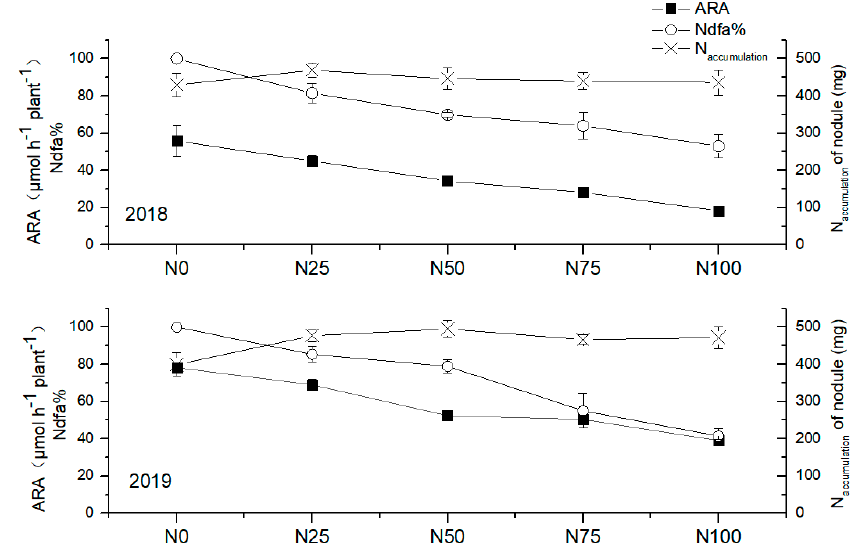
Figure 1. The effects of the concentration of nitrogen supplied on the ARA, Ndfa%, and N accumulation of nodules in soybean plants of experiment I (mean and SE). ARA ( μ mol h − 1 plant − 1 ) represents acetylene reduction activity, Ndfa% represents the percent of nitrogen derived from the atmosphere, and N accumulation of nodules (mg) represents the accumulation of nitrogen fixed by root nodules. Five concentrations of nitrogen were established at the N+ side: 0 mg/L (N0), 25 mg/L (N25), 50 mg/L (N50), 75 mg/L (N75), and 100 mg/L (N100).